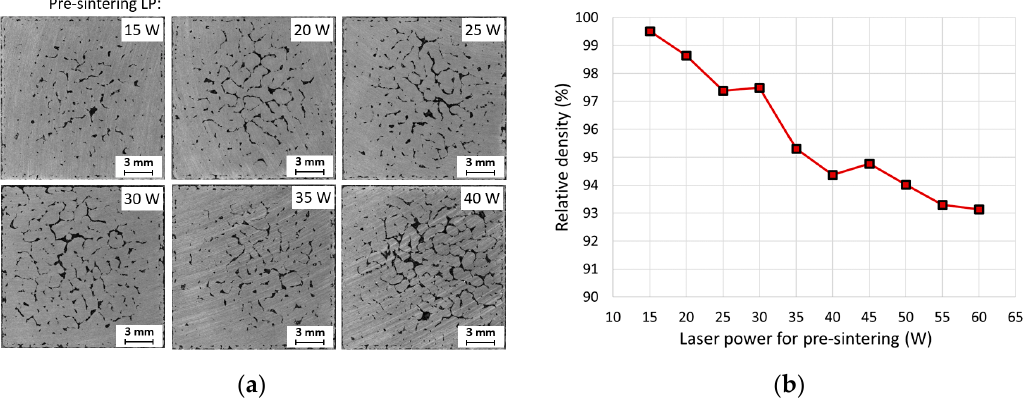
Figure 11. Defects in cube samples fabricated by pre-sintering strategy; ( a ) metallography, top view of sample’s cross section; ( b ) dependence of relative density and laser power.